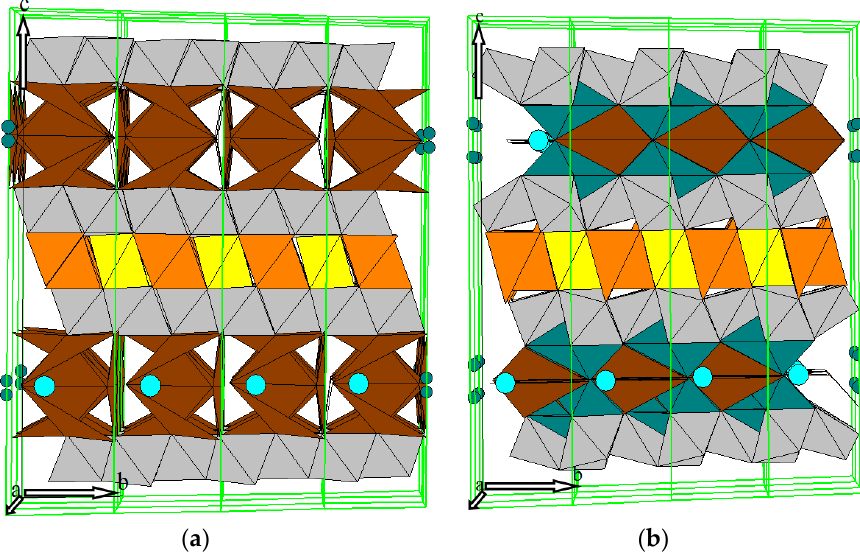
Figure 10. The oxygen environments of Fe atoms represented as tetrahedra and octahedra in two modifications of BaFeHF phase: ( a ) BaFeHF co-pre ; ( b ) BaFeHF r . The colors correspond to groups of atoms as defined in Fig.1b, c —Fe 1 ; —Fe 2 ; —Fe 3 ; —Fe 4 ; —Fe 5 ; —Ba.